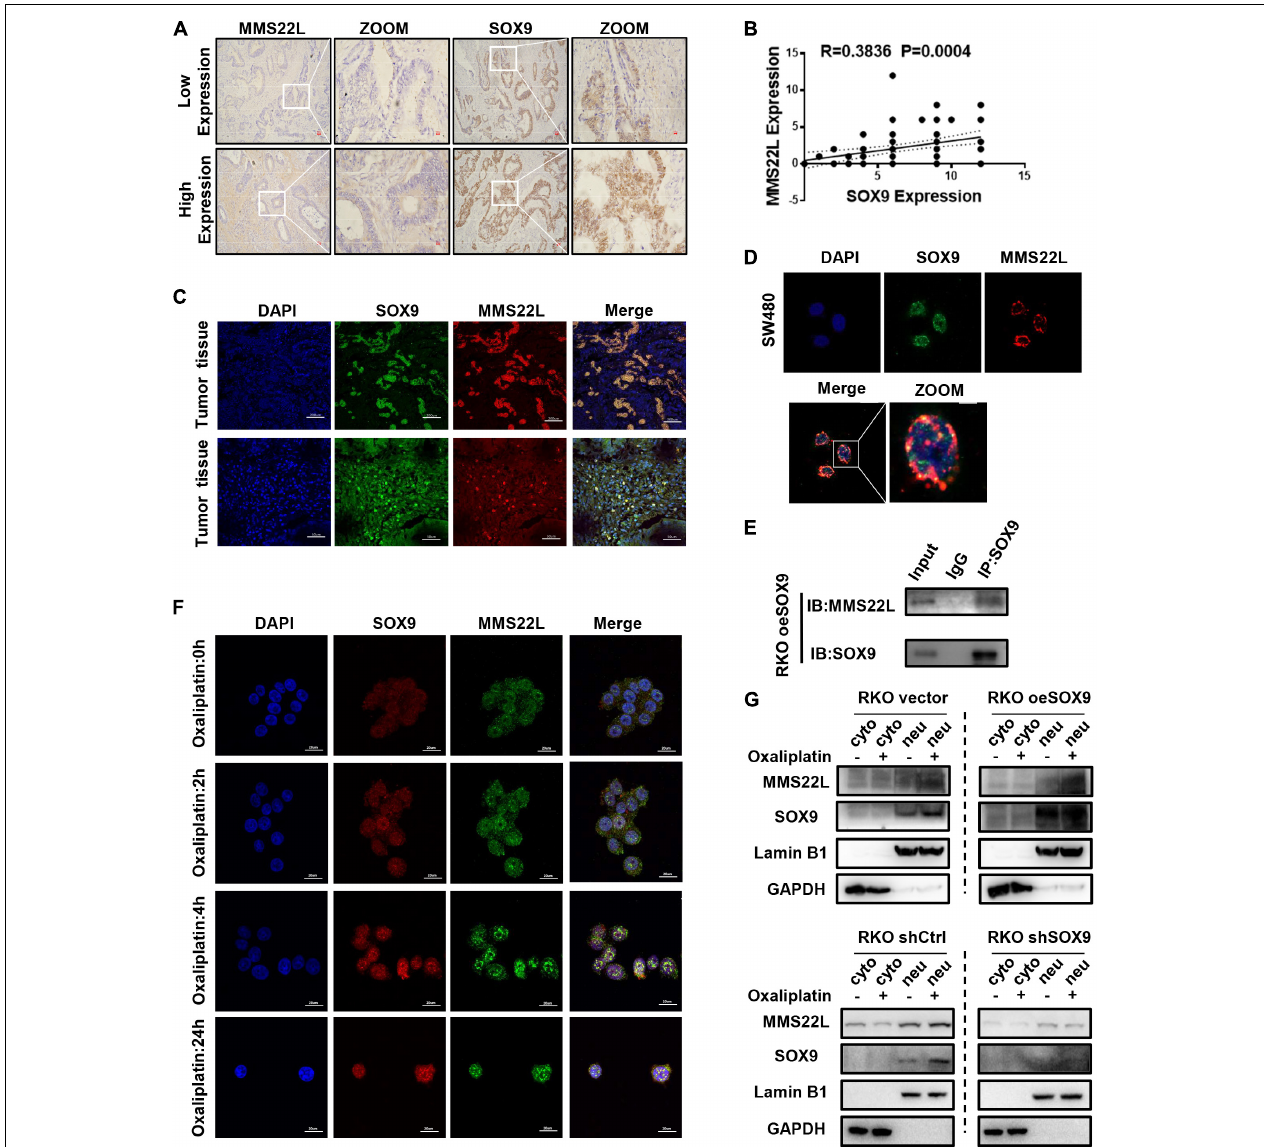
FIGURE 3 | SOX9 enhances chemotherapeutic insensitivity in colorectal cancer by promoting MMS22L expression and nuclear translocation. (A) Representative images showing IHC staining of SOX9 and MMS22L in 2 CRC patients. Scale bar = 50 µ m. (B) The correlation between SOX9 and MMS22L expression was analyzed in 80 CRC patients. (C,D) Representative immunofluorescence images showing SOX9 and MMS22L colocalization in CRC tissues and cell lines (scale bar = 20, 50, or 200 µ m). (E) IP analysis of the interaction of MMS22L with SOX9 in SOX9-overexpressing RKO cells. (F) Immunofluorescence images showing the time-dependent variation in SOX9 and MMS22L colocalization in RKO cells treated with oxaliplatin. Scale bar = 20 µ m. (G) Nuclear fractions were extracted from CRC cells, and the nuclear (neu) and cytoplasmic (without the nucleus; cyto) fractions were prepared. Immunoblot showing the protein levels of MMS22L and SOX9 expressed in Vector and oeSOX9 RKO cells and in shCtrl and shSOX9 RKO